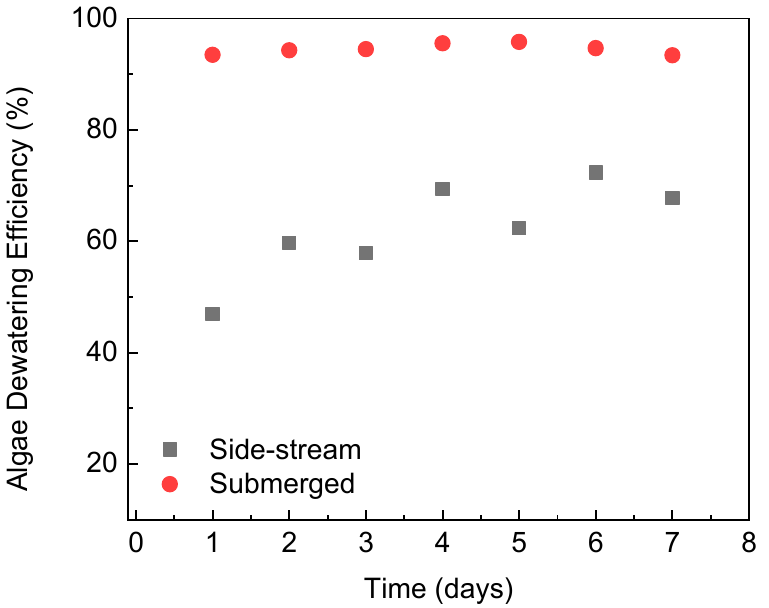
Figure 4. Algae dewatering efficiency at the end of each FO experiment when 750 mL of permeate was collected.